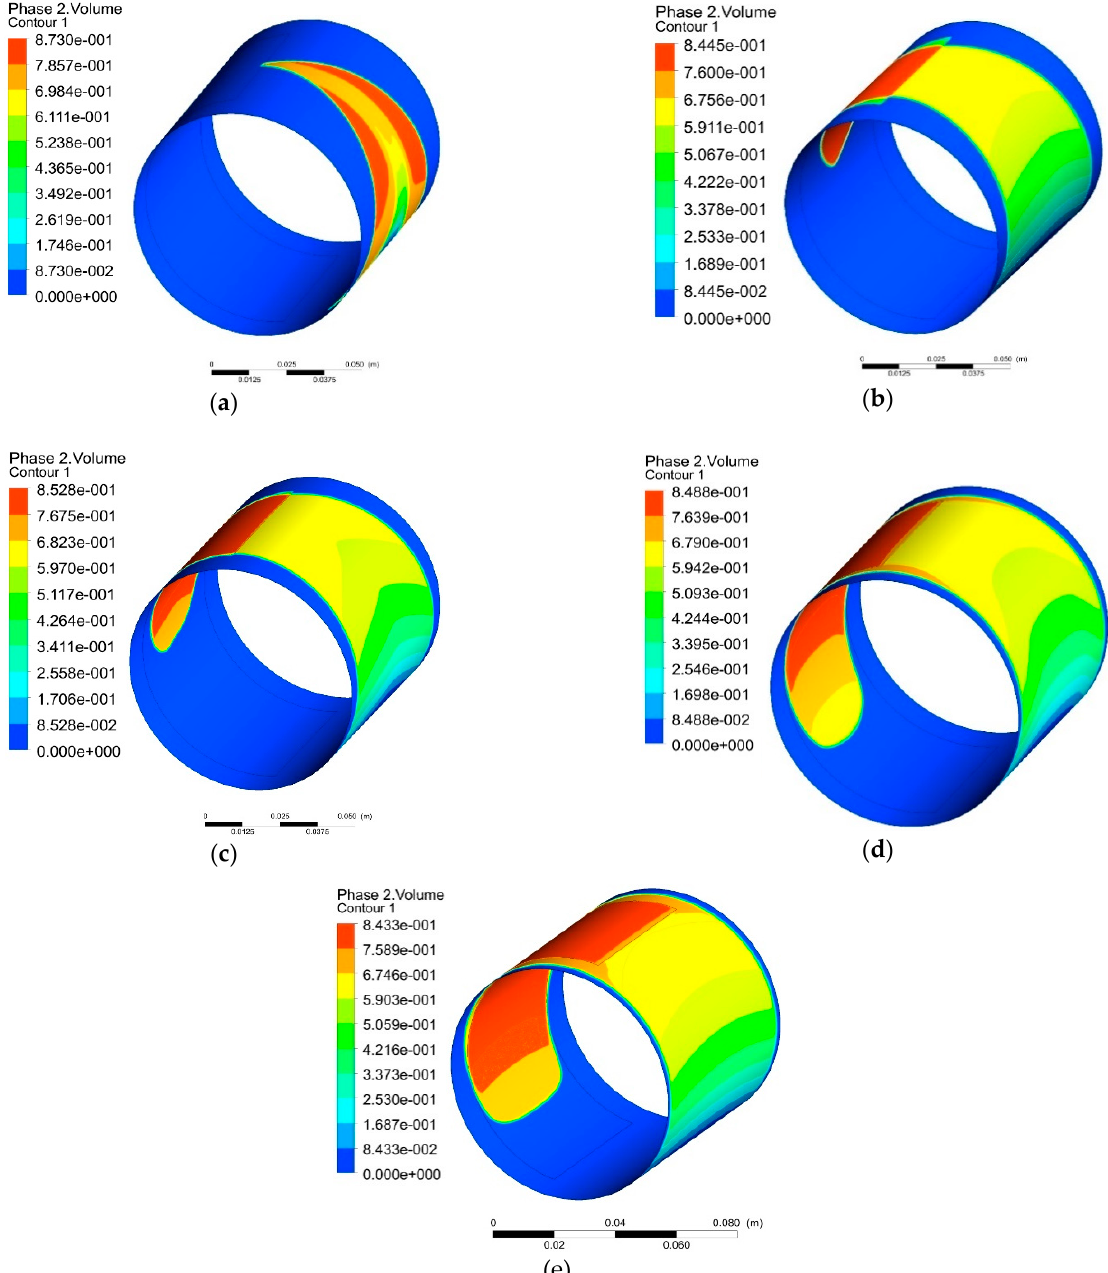
Figure 15. Profile of vapor volume fraction of the heterogeneous slip/no-slip bearing for different rotational velocity n . All results are evaluated at z / L = 0.5.